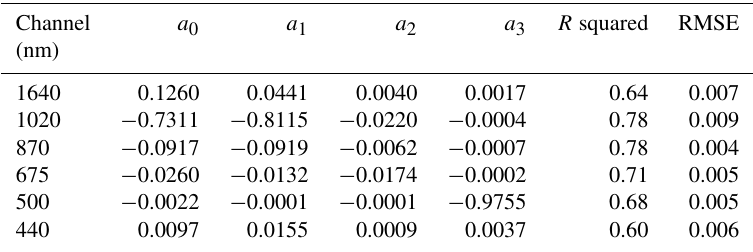
Table 1. Results of (cid:49) AOD fit parameterization for each channel: model coefficients, coefficient of determination ( R squared) and root-mean- squared error (RMSE) within 95% confidence bounds.